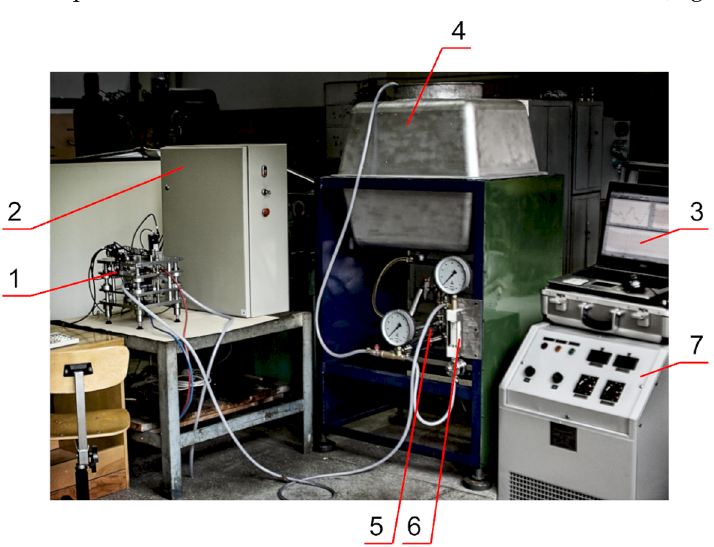
Figure 14. Test stand: processing part 1, the control system 2, computer 3, electrolyte tank 4, hydraulic pump 5, flow regulator 6, DC power supply 7.